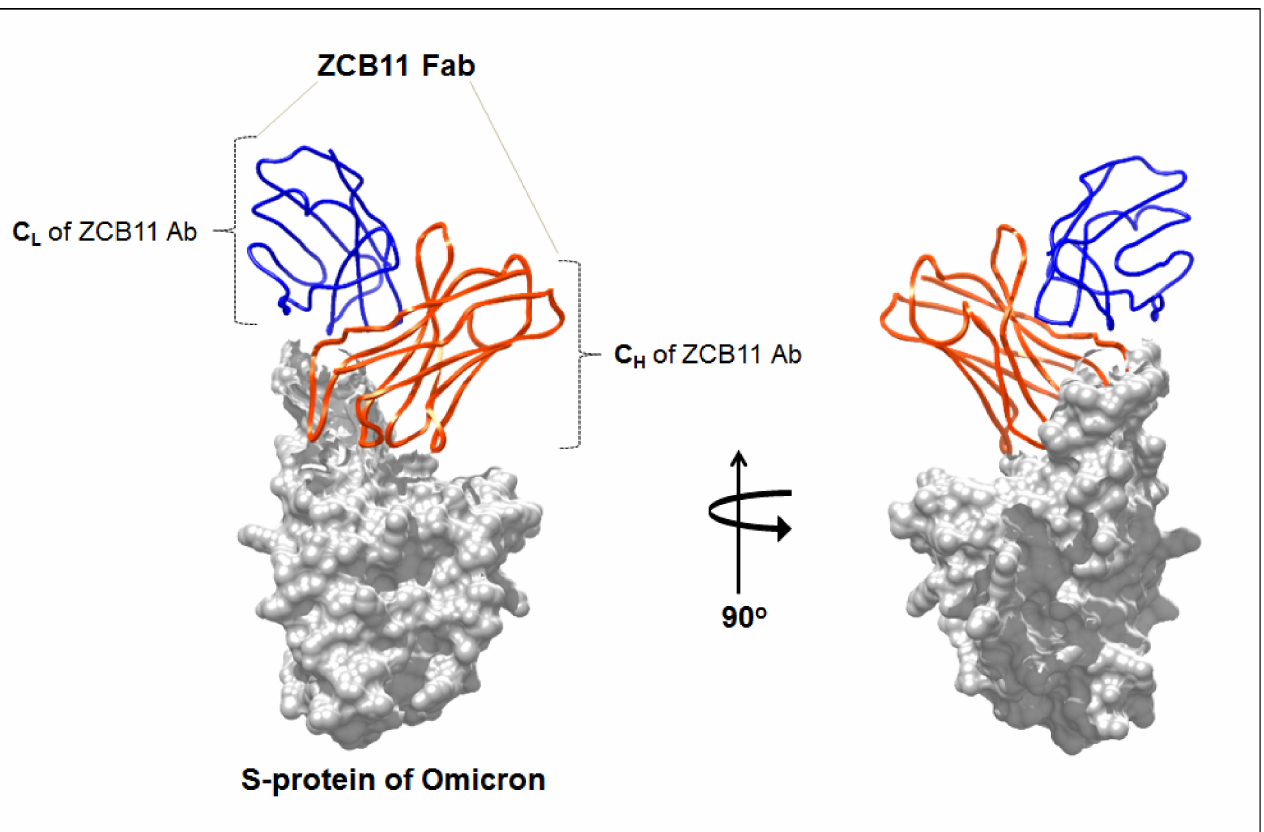
Figure 7. The figure shows the interaction structure of neutralizing antibodies (nAb) with the Omicron spike protein. It shows the interaction Fab fragment of ZCB11 against the SARS-CoV-2 Omicron spike. The structure was developed from a PDB file (PDB id: